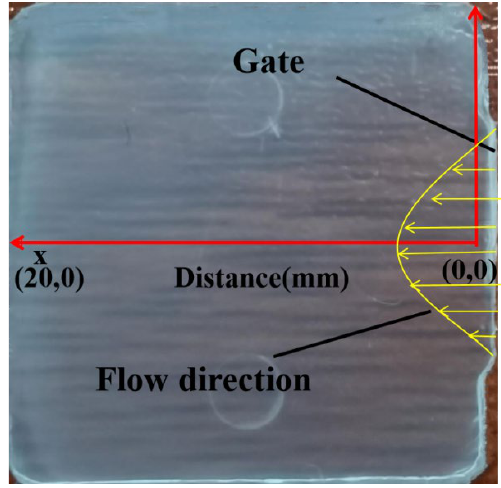
Figure 3. Physical drawing of the part.